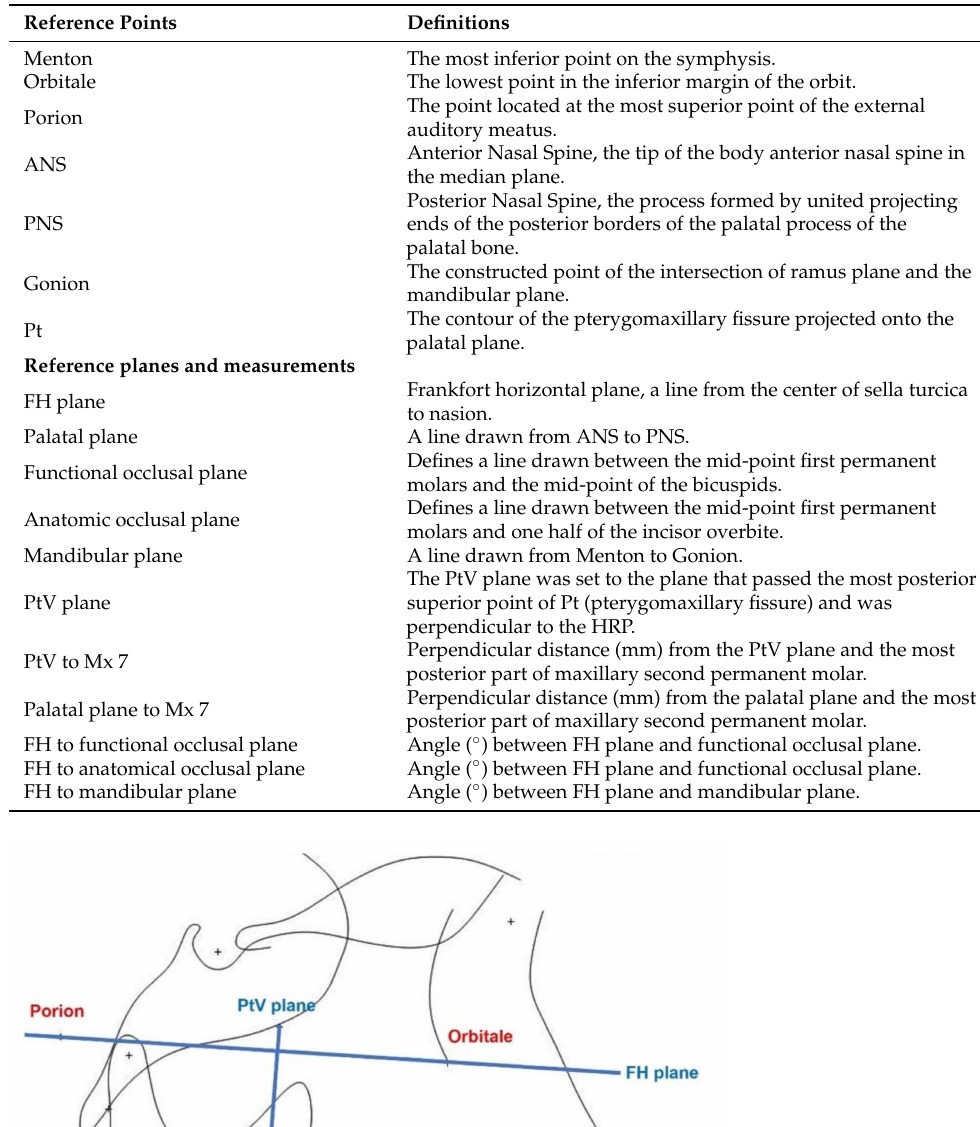
Table 2. Definition of landmarks, reference planes, and measurements used in this study.